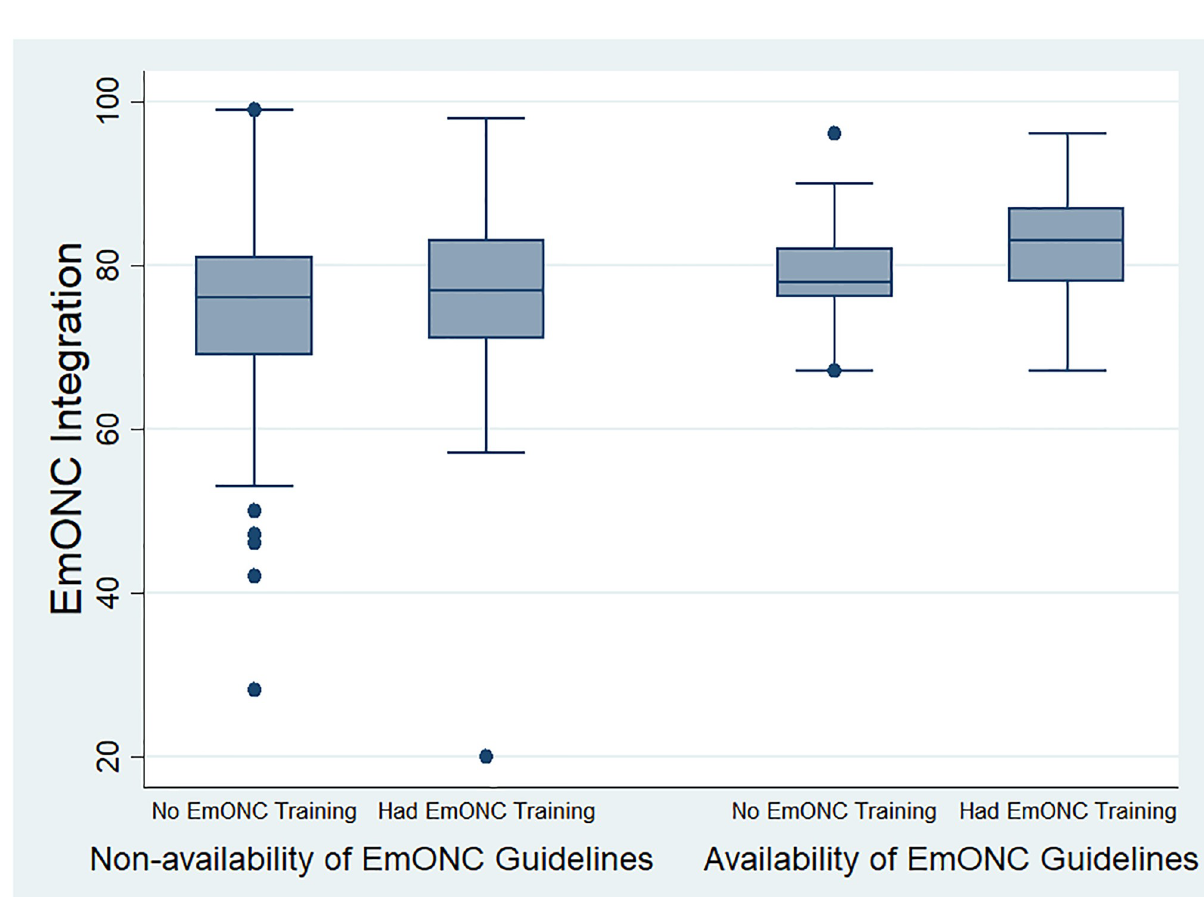
Fig 2. Integration of EmONC by training and guidelines.